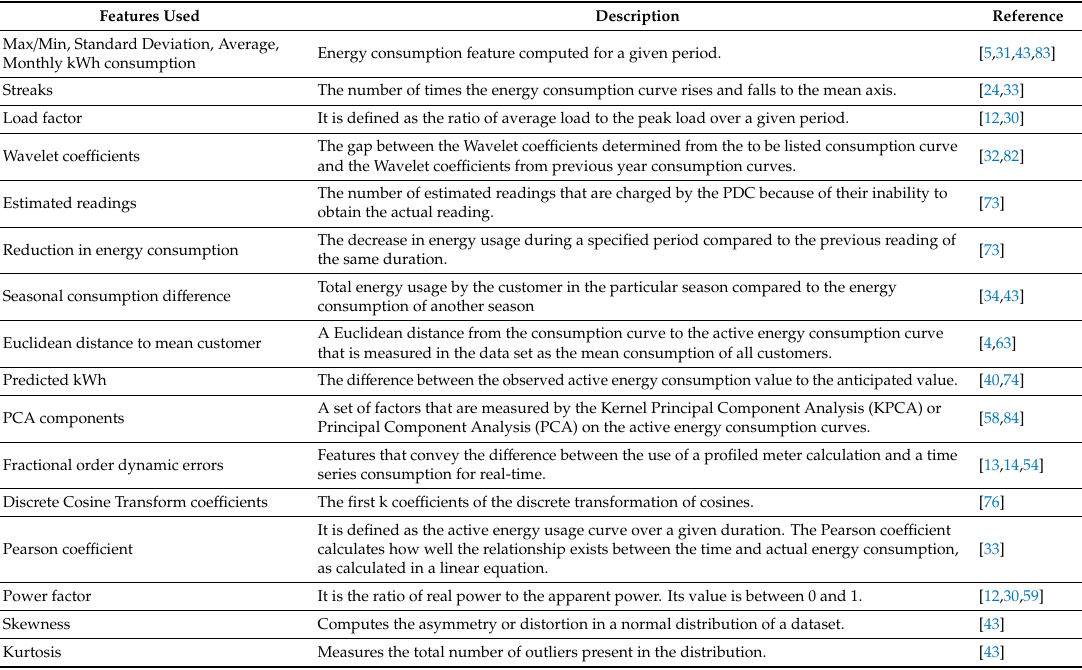
Table 3. List of most commonly used features in the literature for non-technical losses (NTL) detection. Features Used